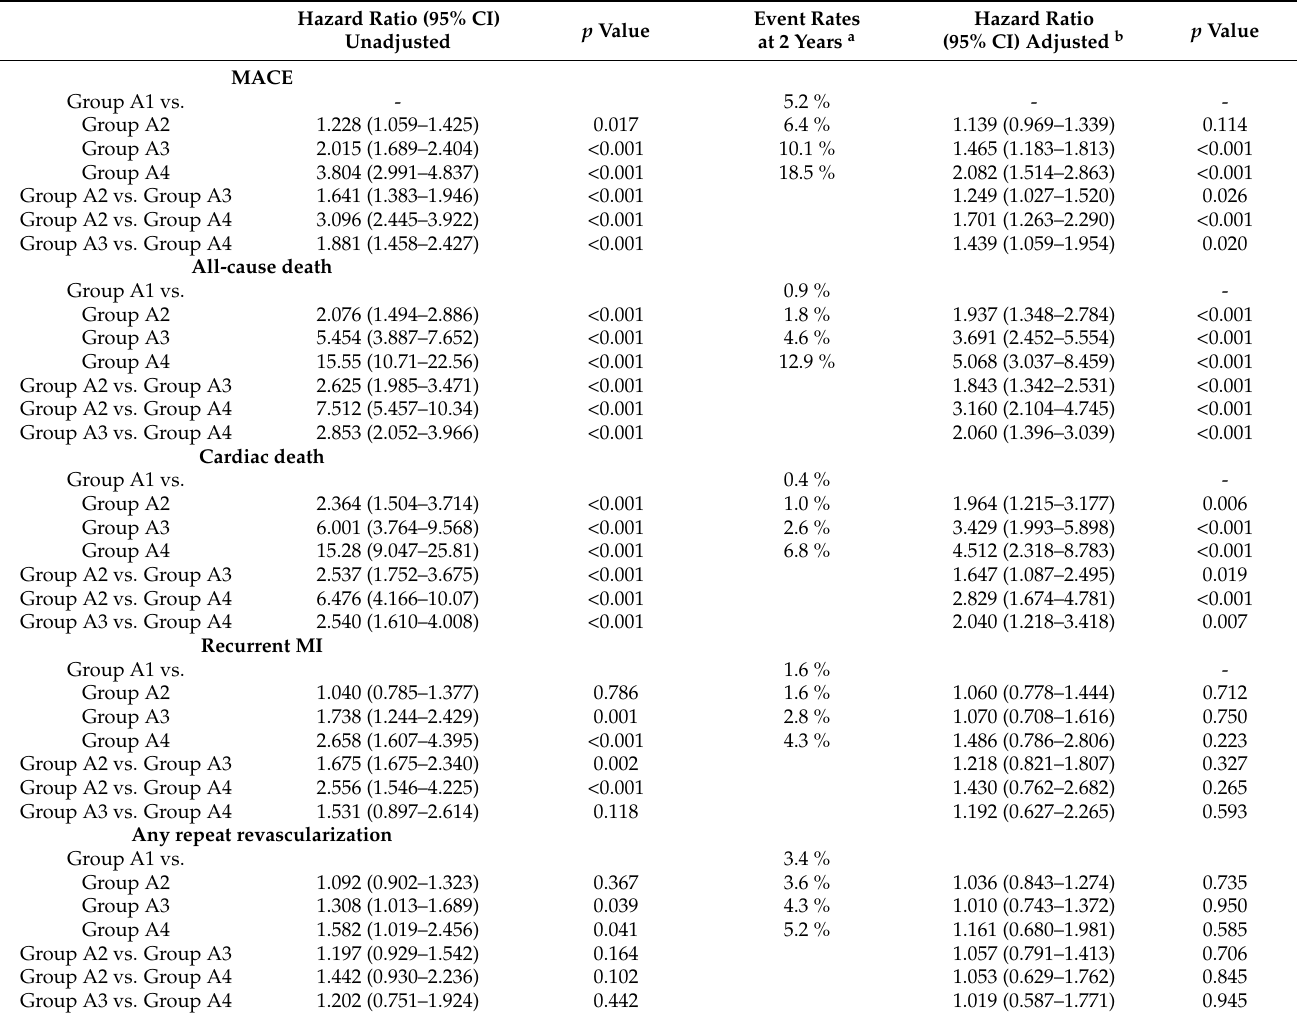
Table 5. Hazard ratios for the 2-year major clinical outcomes in statin